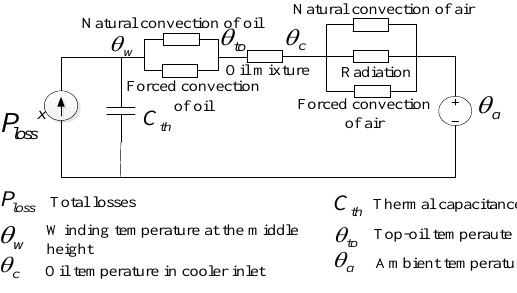
Figure 3. Thermal-electrical analogy of the advanced thermal model [54]. Figure 21. Thermal-electrical analogy of the advanced thermal model [54].